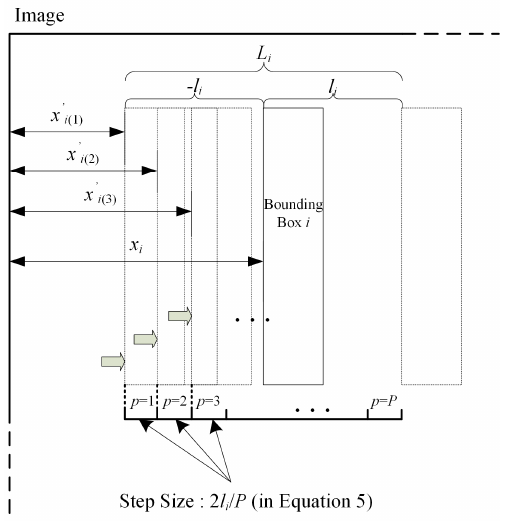
Figure 5. The translation process of the i -th BB.